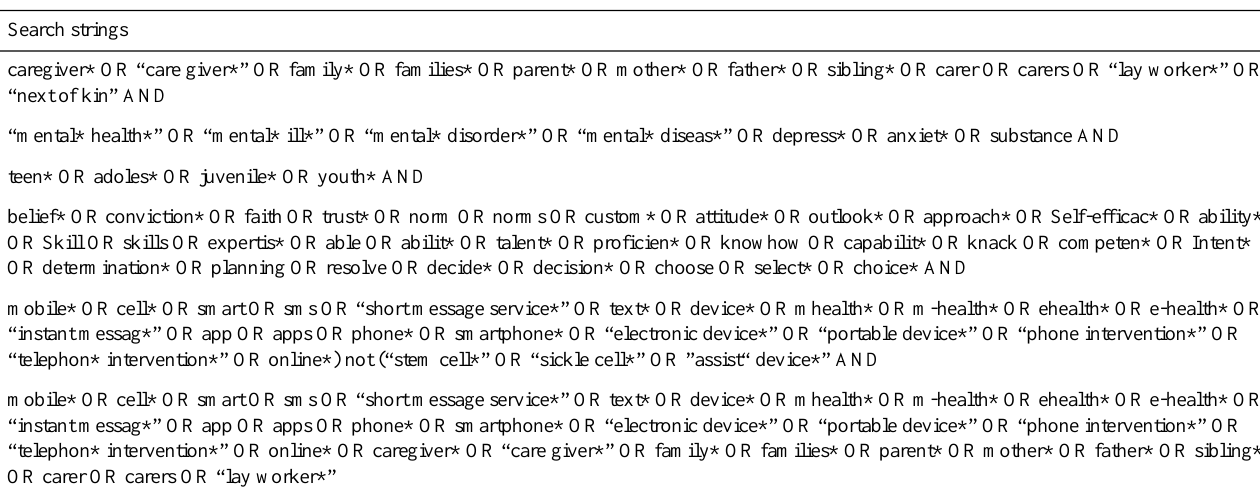
Table 2. Search strings